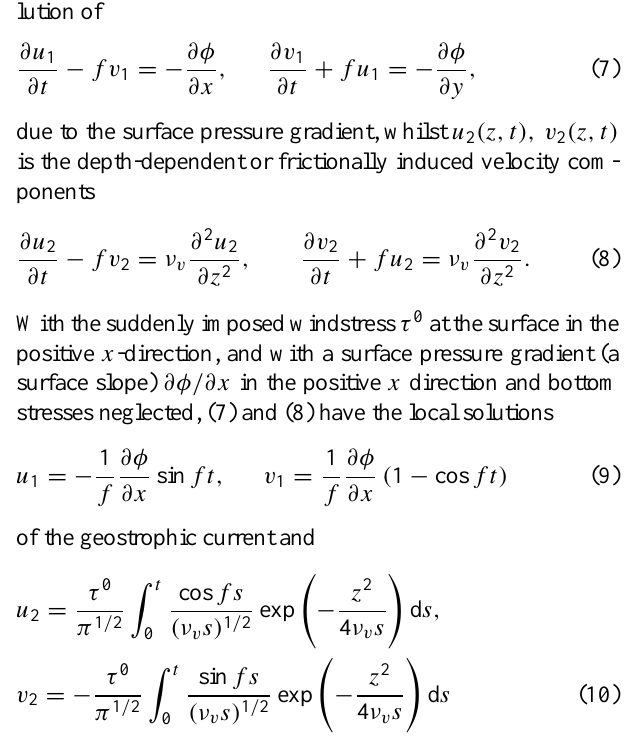
FIG. 3: Time series of the horizontal velocity components u (a) and v (b) in the rectangular basin subject to constant wind from West computed with constant vertical eddy viscosity ν v = 0 . 005m 2 s − 1 . The labels on curves stand for depth in meters.